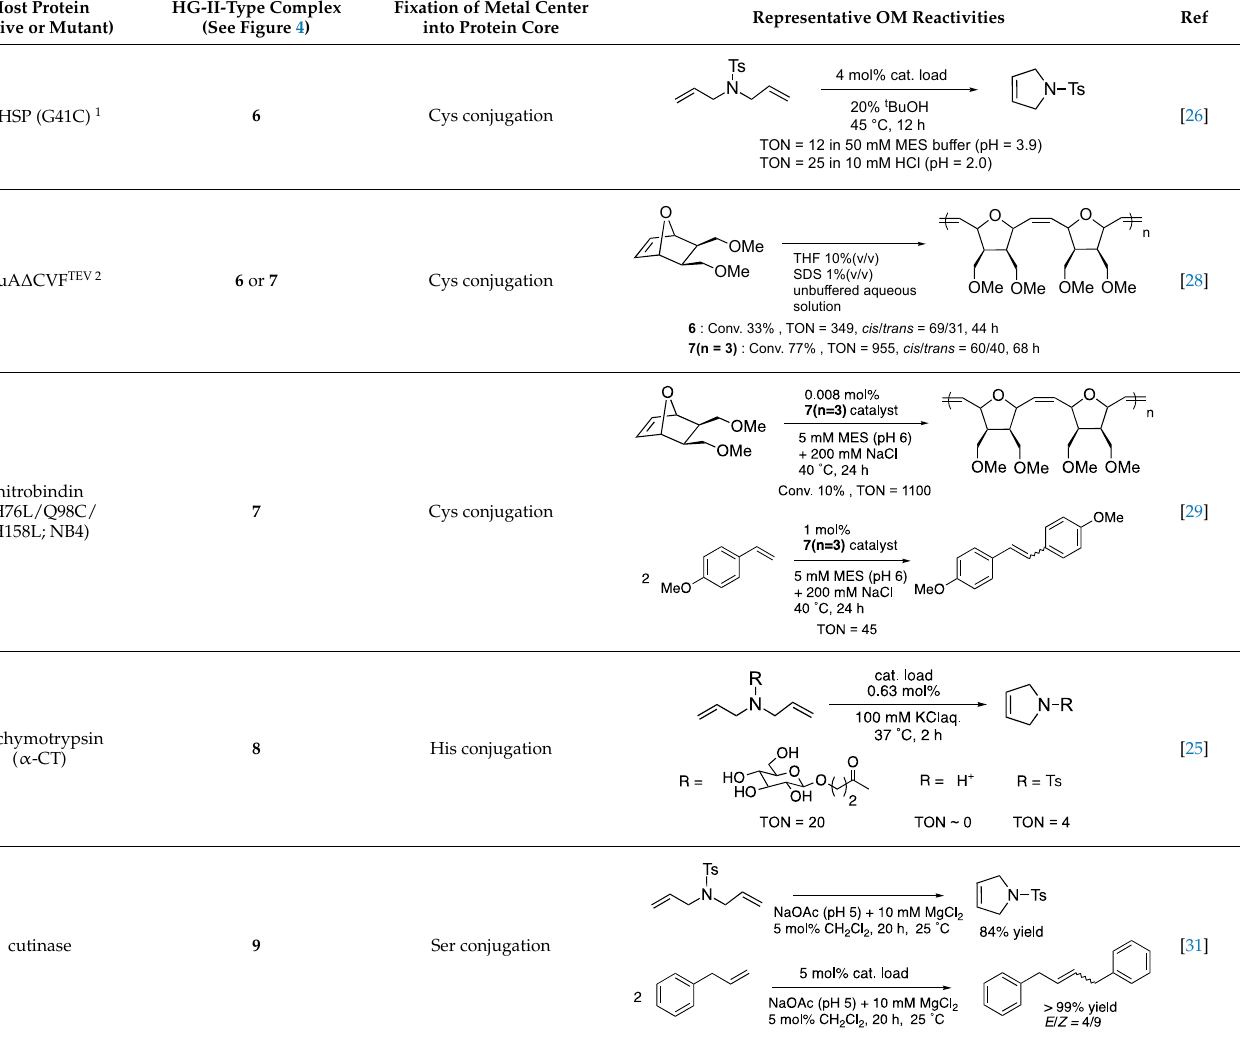
Host Protein Table 1. Hybrid artificial metalloenzymes with olefin metathesis activity (OM-ArMs). (Native or